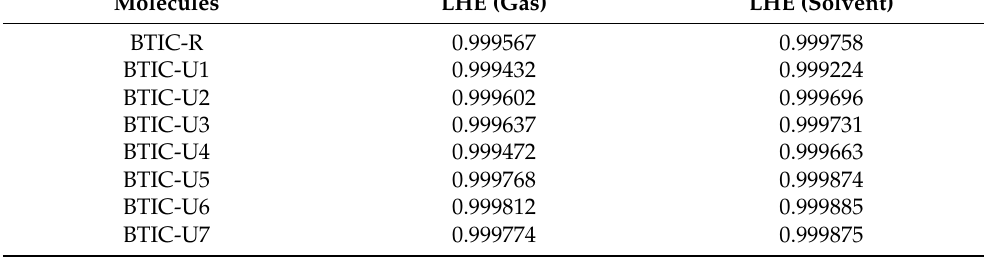
Table 4. LHE of BTIC-R and BTIC-U1 to BTIC-U7 in the gas and chloroform solvent.